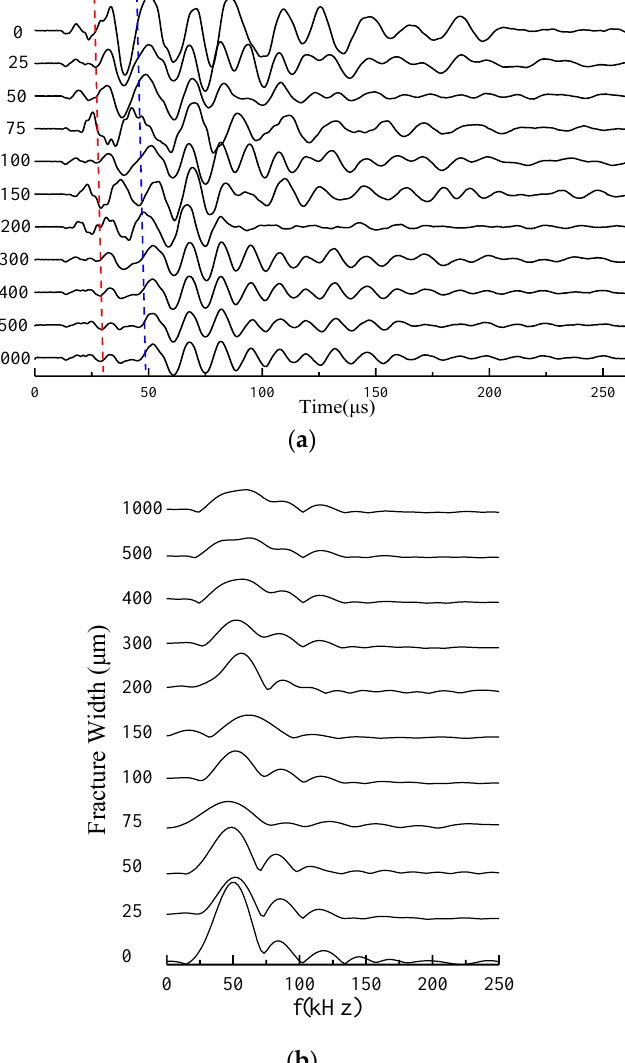
Figure 9. Experimental shear waveforms of core sample B1 at different fracture width conditions ( a ) and the corresponding S-wave spectrum ( b ). The red and blue dashed lines, respectively, illustrate the start and end positions of the target time window for S-wave-energy analysis in ( a ), and the positions of the red and blue dashed line indicators are determined by the S-wave arrivals and the length of the time window.